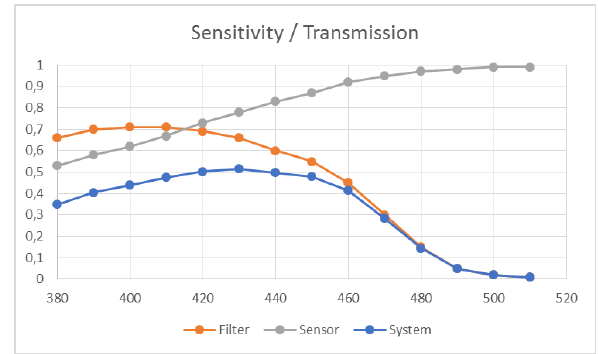
Figure 3. DigiCAM 100 camera heads mounted at the belly of the aircraft (left: RGB, right: Coastal Blue with filter in front of the lens)